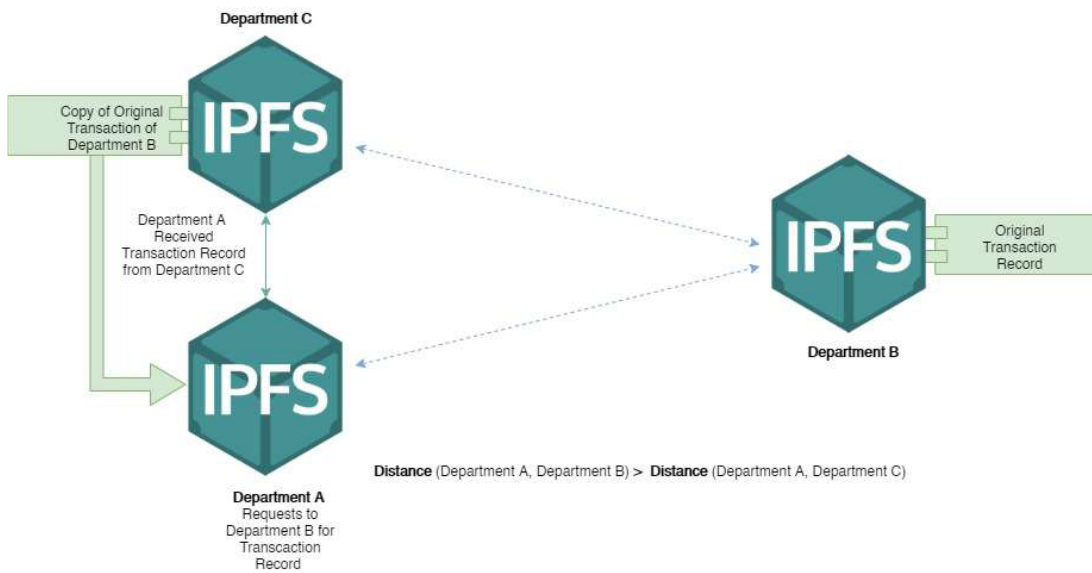
10 of 25 Algorithm 2: Local Fog Node Data Filtering and Preprocessing 1